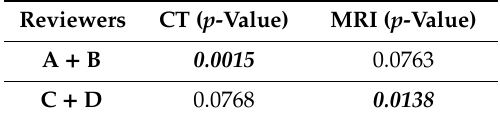
Significant values ( p < 0.05) are given in bold italics.